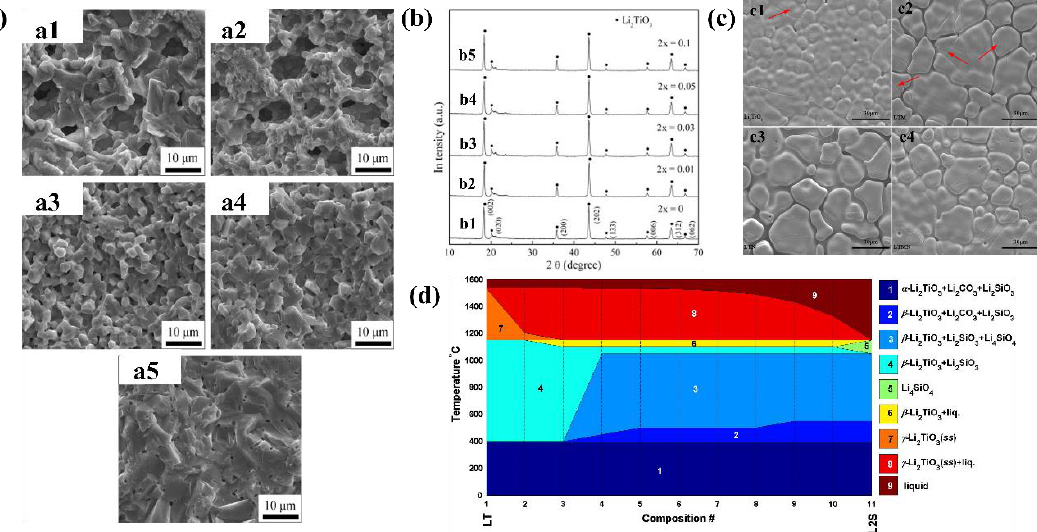
Figure 11. SEM images of the fracture surface of Li 2−2x Mg 2x TiO 3+ x pellets sintered at 1100 °C for 6 h. ( a1 ) Li 2 TiO 3 , ( a2 ) Li 1 . 99 Mg 0 . 01 TiO 3 . 005 , ( a3 ) Li 1 . 97 Mg 0 . 03 TiO 3 . 015 , ( a4 ) Li 1 . 95 Mg 0 . 05 TiO 3 . 025 , and ( a5 ) Li 1 . 90 Mg 0 . 1 TiO 3 . 05 . ( b ) X-ray diffraction patterns of Mg-doped lithium titanate. (b1) 2x=0; (b2) 2x=0.01; (b3) 2x=0.03; (b4) 2x=0.05; (b5) 2x=0.1. Reprinted with permission from ref. [122]. ( c ) Surface morpholo- gies of (c1) pure Li 2 TiO 3 ; (c2) LTM; (c3) LTN; (c4) LTMN. Reprinted with permission from ref. [123].